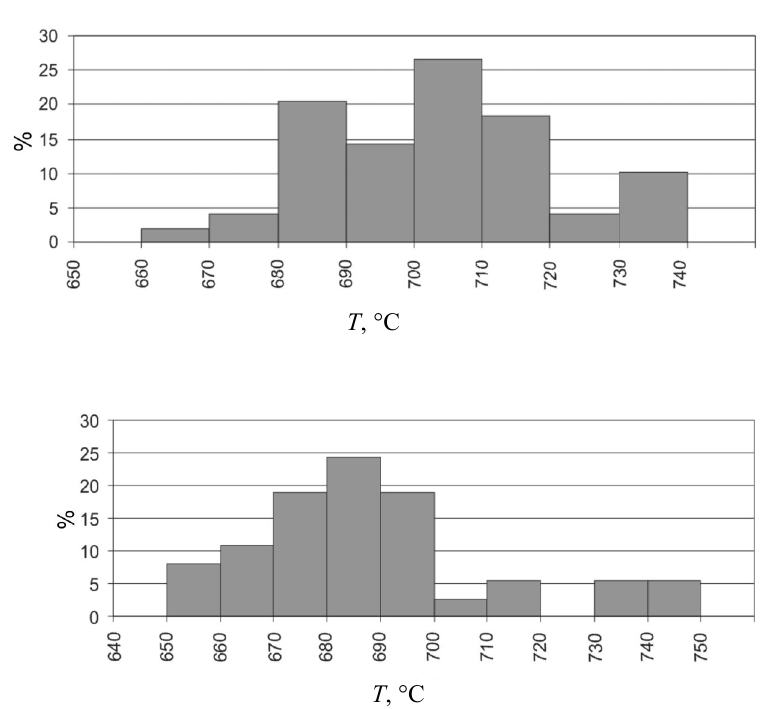
Fig. 6. Percentage distribution of ground- mass quartz crystallization temperatures in the Suursaari quartz